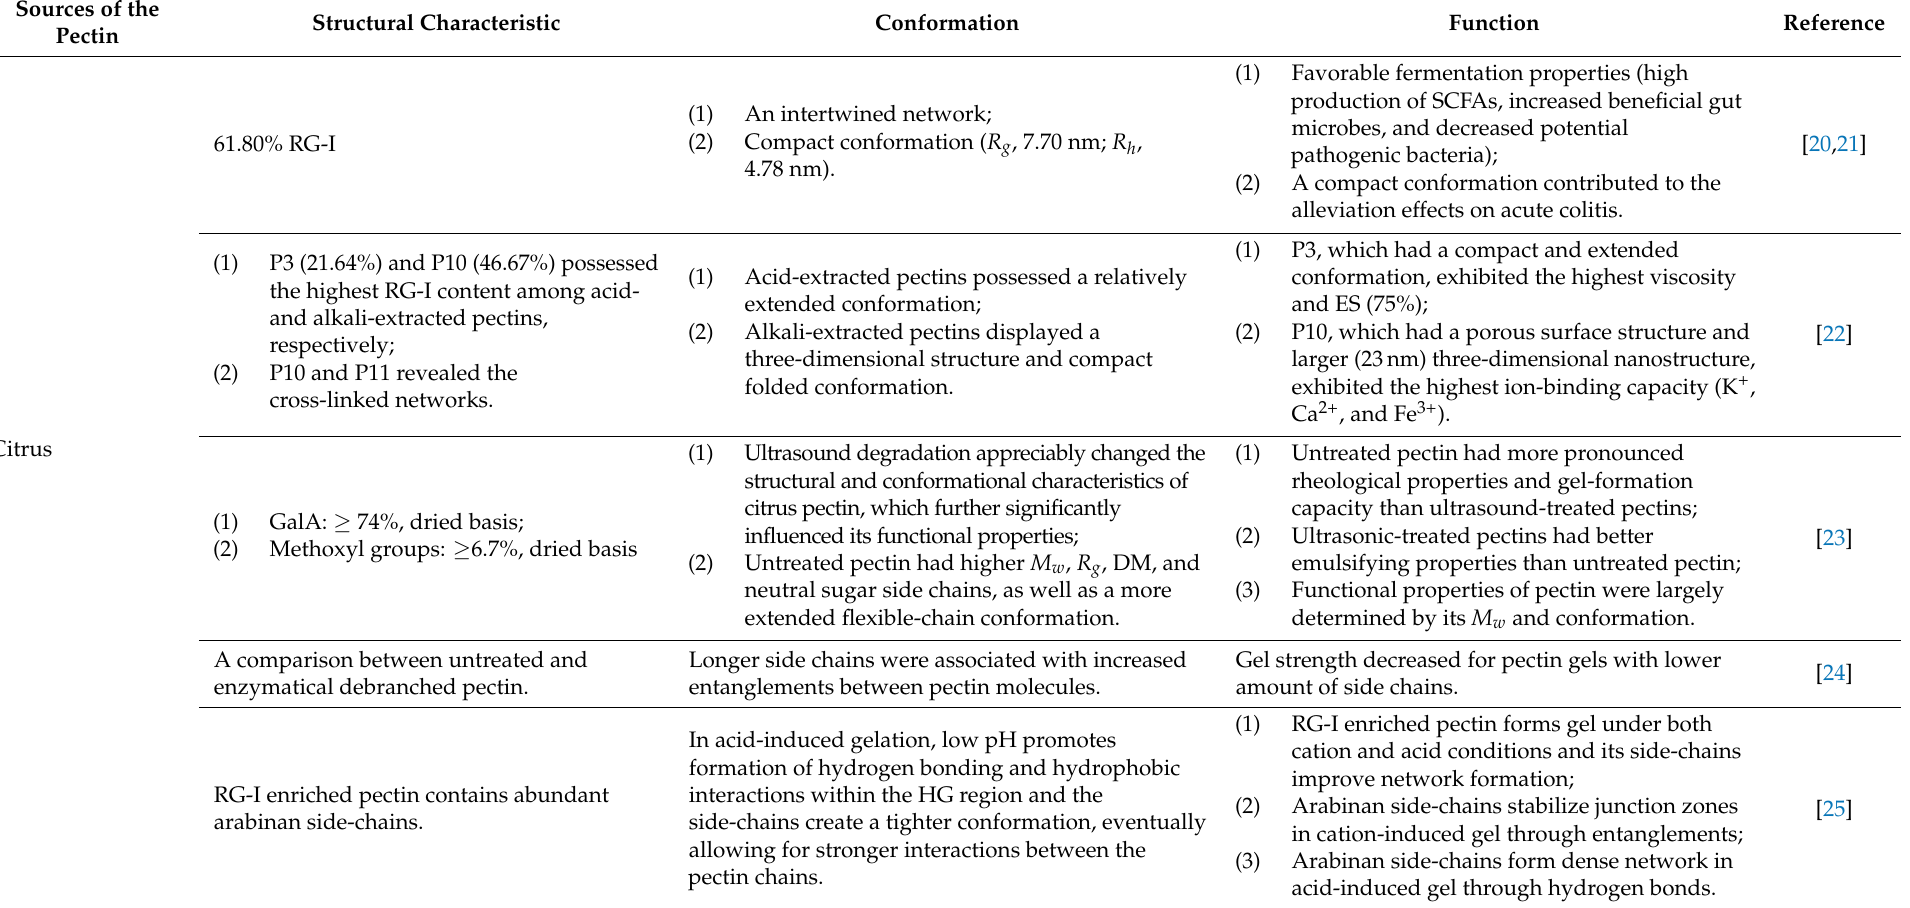
Table 2. Structural–conformational–functional relationships of pectins from various plant